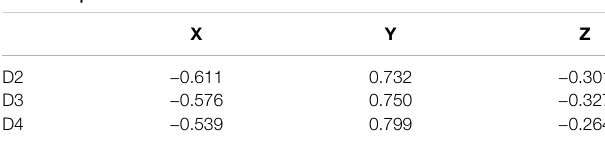
TABLE 1 | Normal vectors of the DDs in the GSE